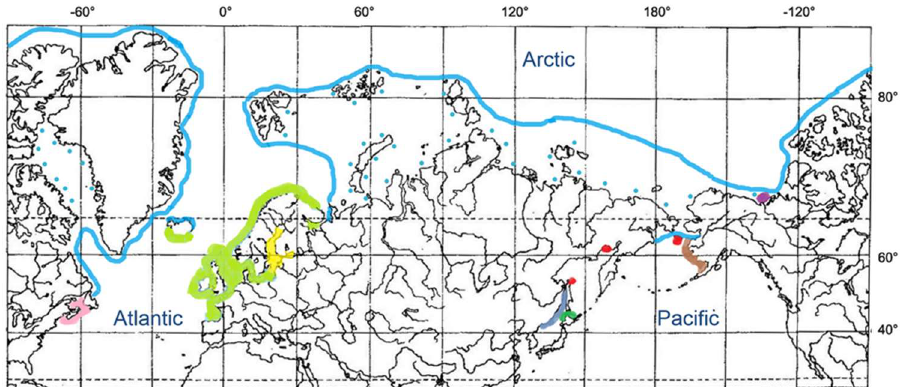
Figure 4. Distribution of the subgenus Liparis group in the Atlantic: lilac line— L. coheni , light green line— L. liparis , and yellow— L. barbatus ; in the Pacific: red dots— L. marmoratus , dark green— L. frenatus , gray— L. brashnikovi , and brown— L. bristolensis ; in the Arctic: blue line— L. tunicatus that occurs mainly in coastal zone (dots) and dark lilac— L. hershelinus .